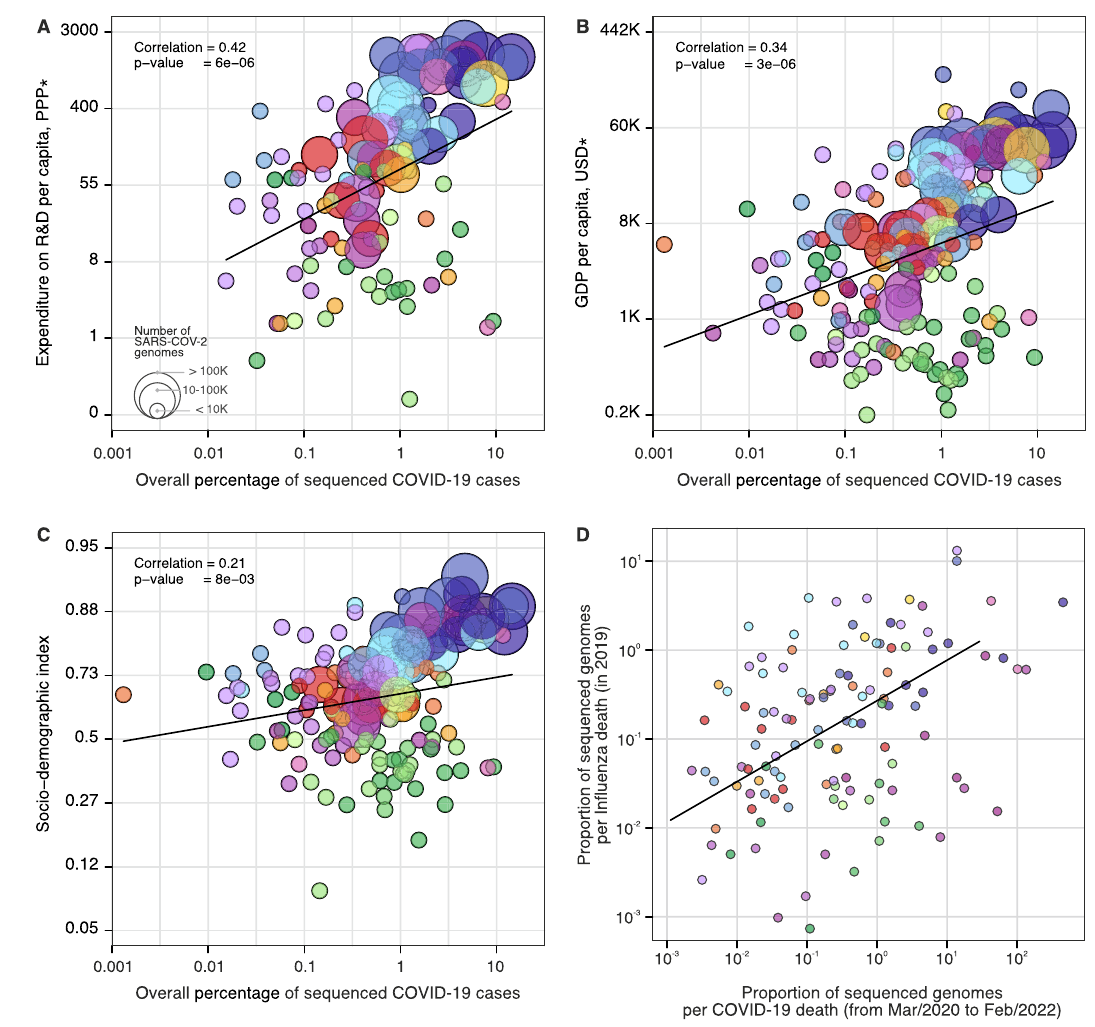
Fig. 4| Casesequencing percentagesandsocioeconomiccovariates. Covariates that show the highest correlation with the overall percentage of COVID-19 sequenced cases (during the period shown in Fig. 1, with geographic regions colored as shown in that fi gure). A Expenditure on R&D per capita (slope=1.30, CI=(0.76, 1.84), t -value=4.76). B GDP per capita (slope=0.75, CI=(0.44, 1.05), t - value=4.83). C Socio-demographic index (slope=0.25, CI=(0.07, 0.44), t